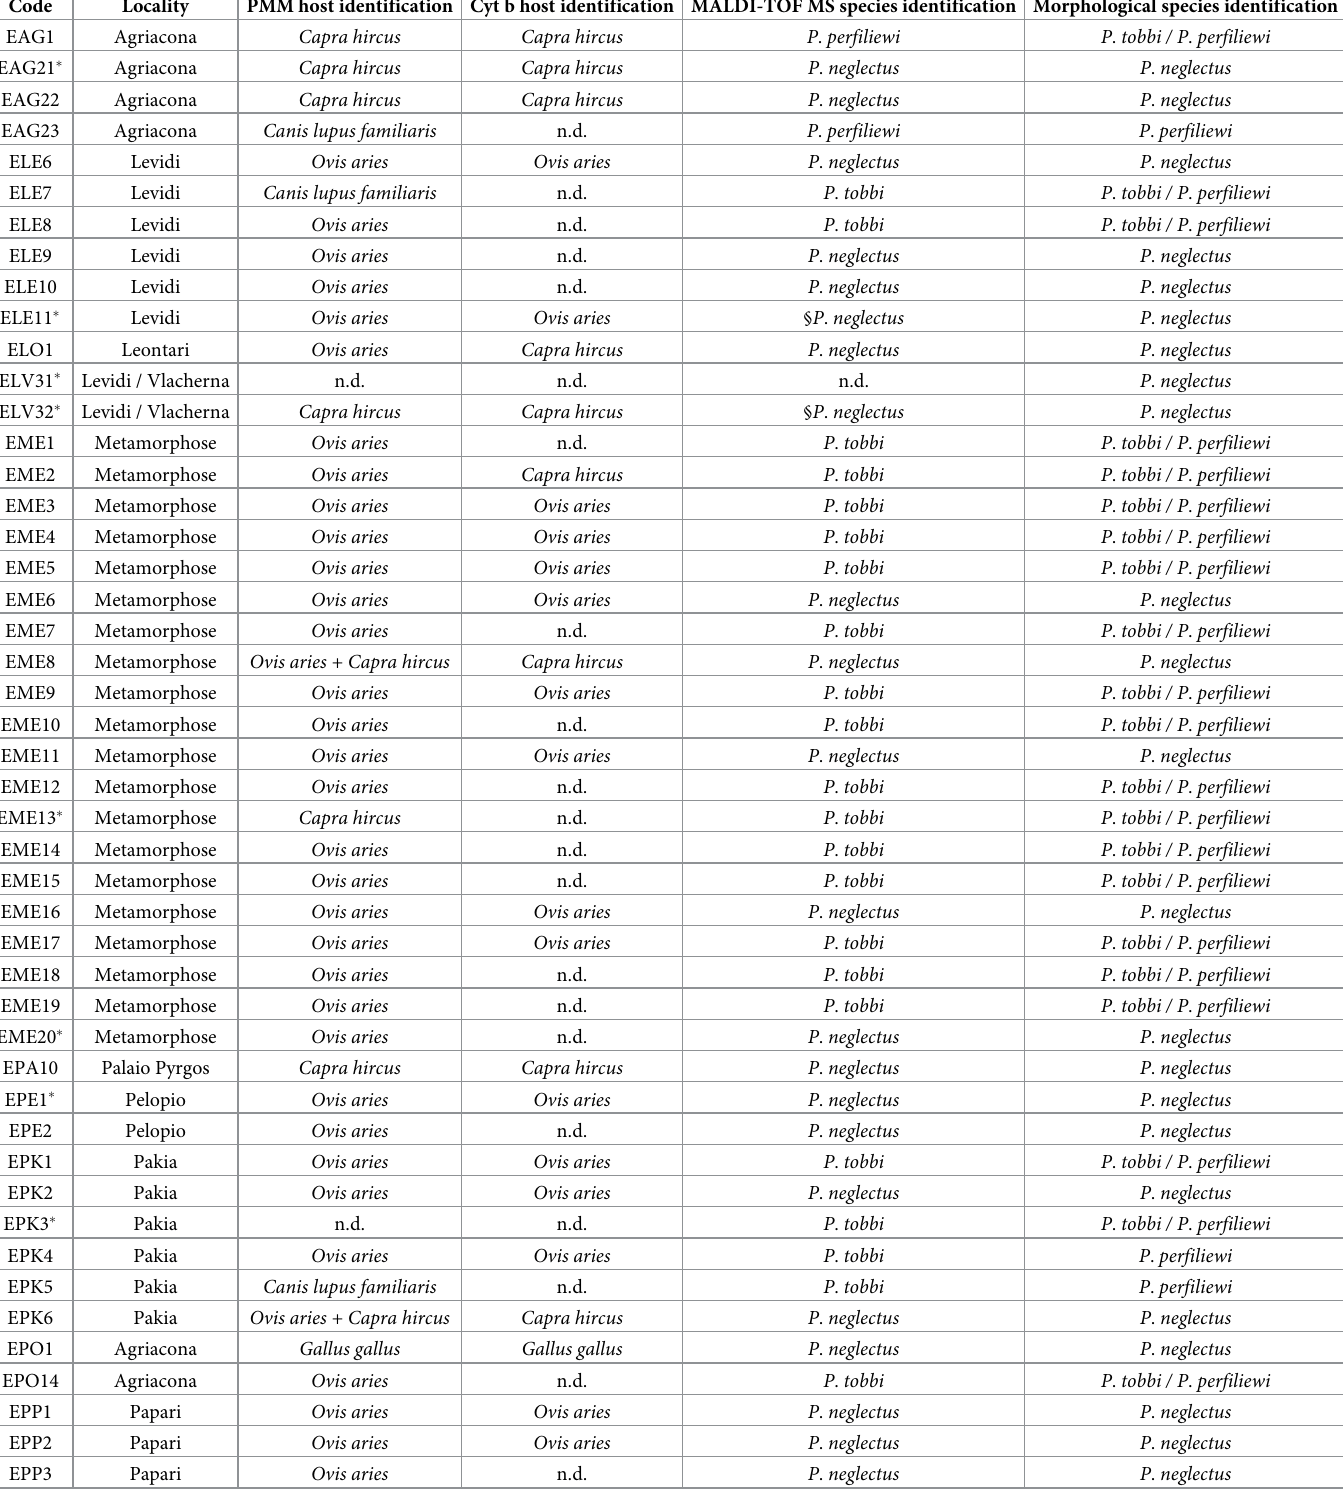
Table 3. List of field-caught engorged females from Greece. Code